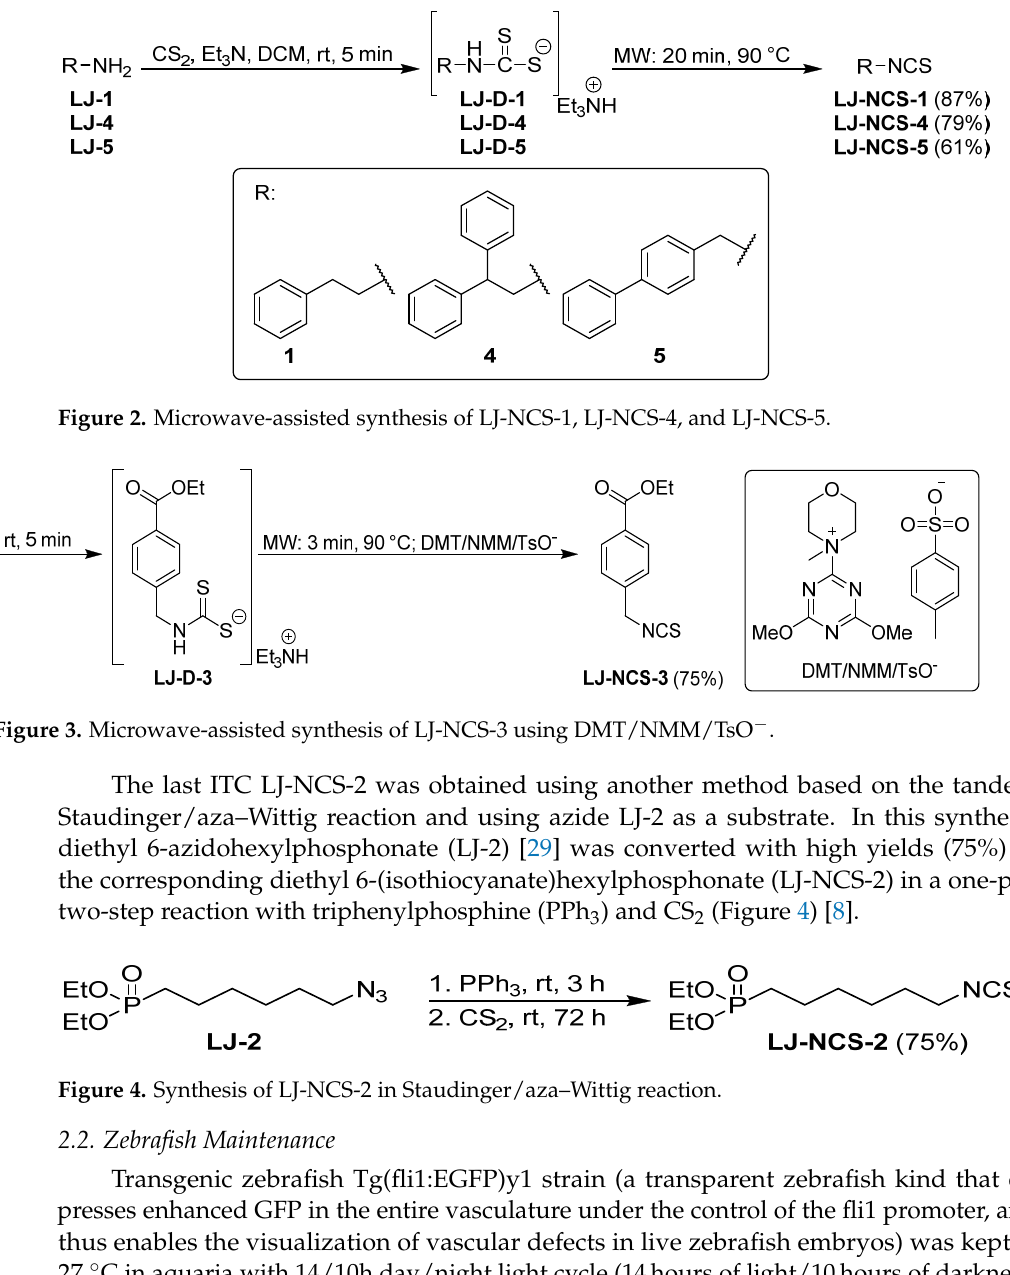
Figure 4. Synthesis of LJ-NCS-2 in Staudinger/aza–Wittig reaction.